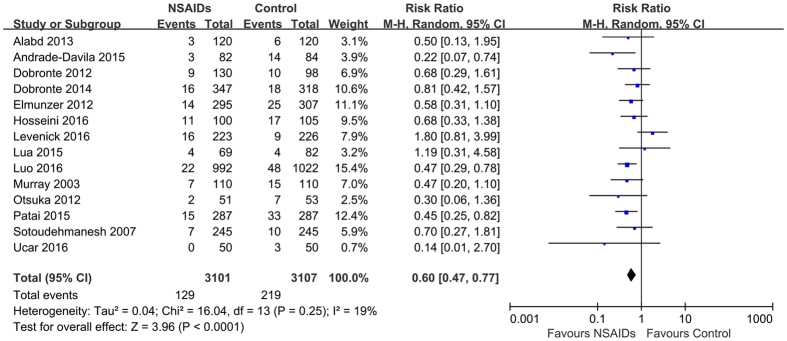
Forest plot showing a significant reduction in the risk of mild post-ERCP pancreatitis with rectal NSAIDs therapy.CI, confidence interval; M-H, Mantel-Haenszel; NSAIDs, nonsteroidal anti-inflammatory drugs; ERCP, endoscopic retrograde cholangiopancreatography.